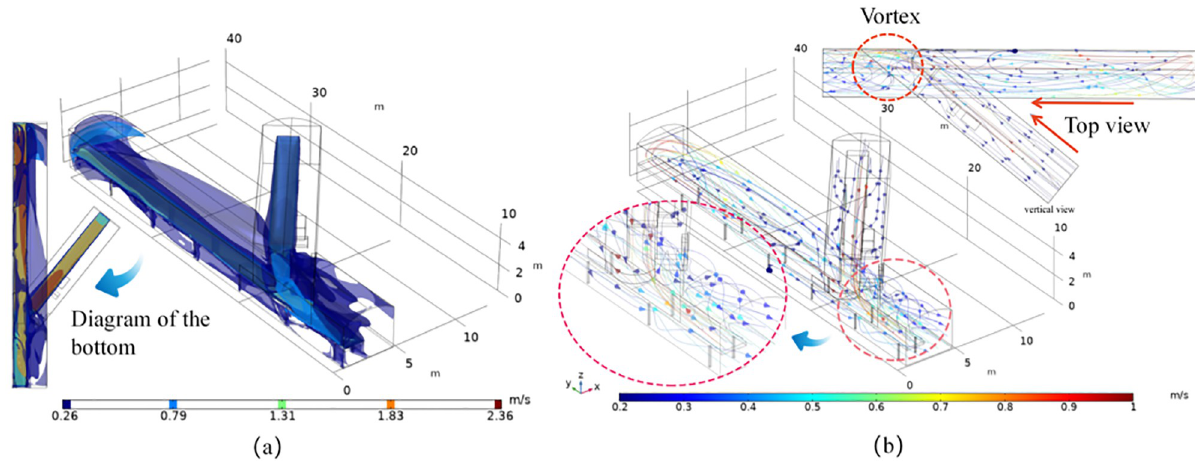
Fig 9. Wind flow distribution characteristics and wind flow line